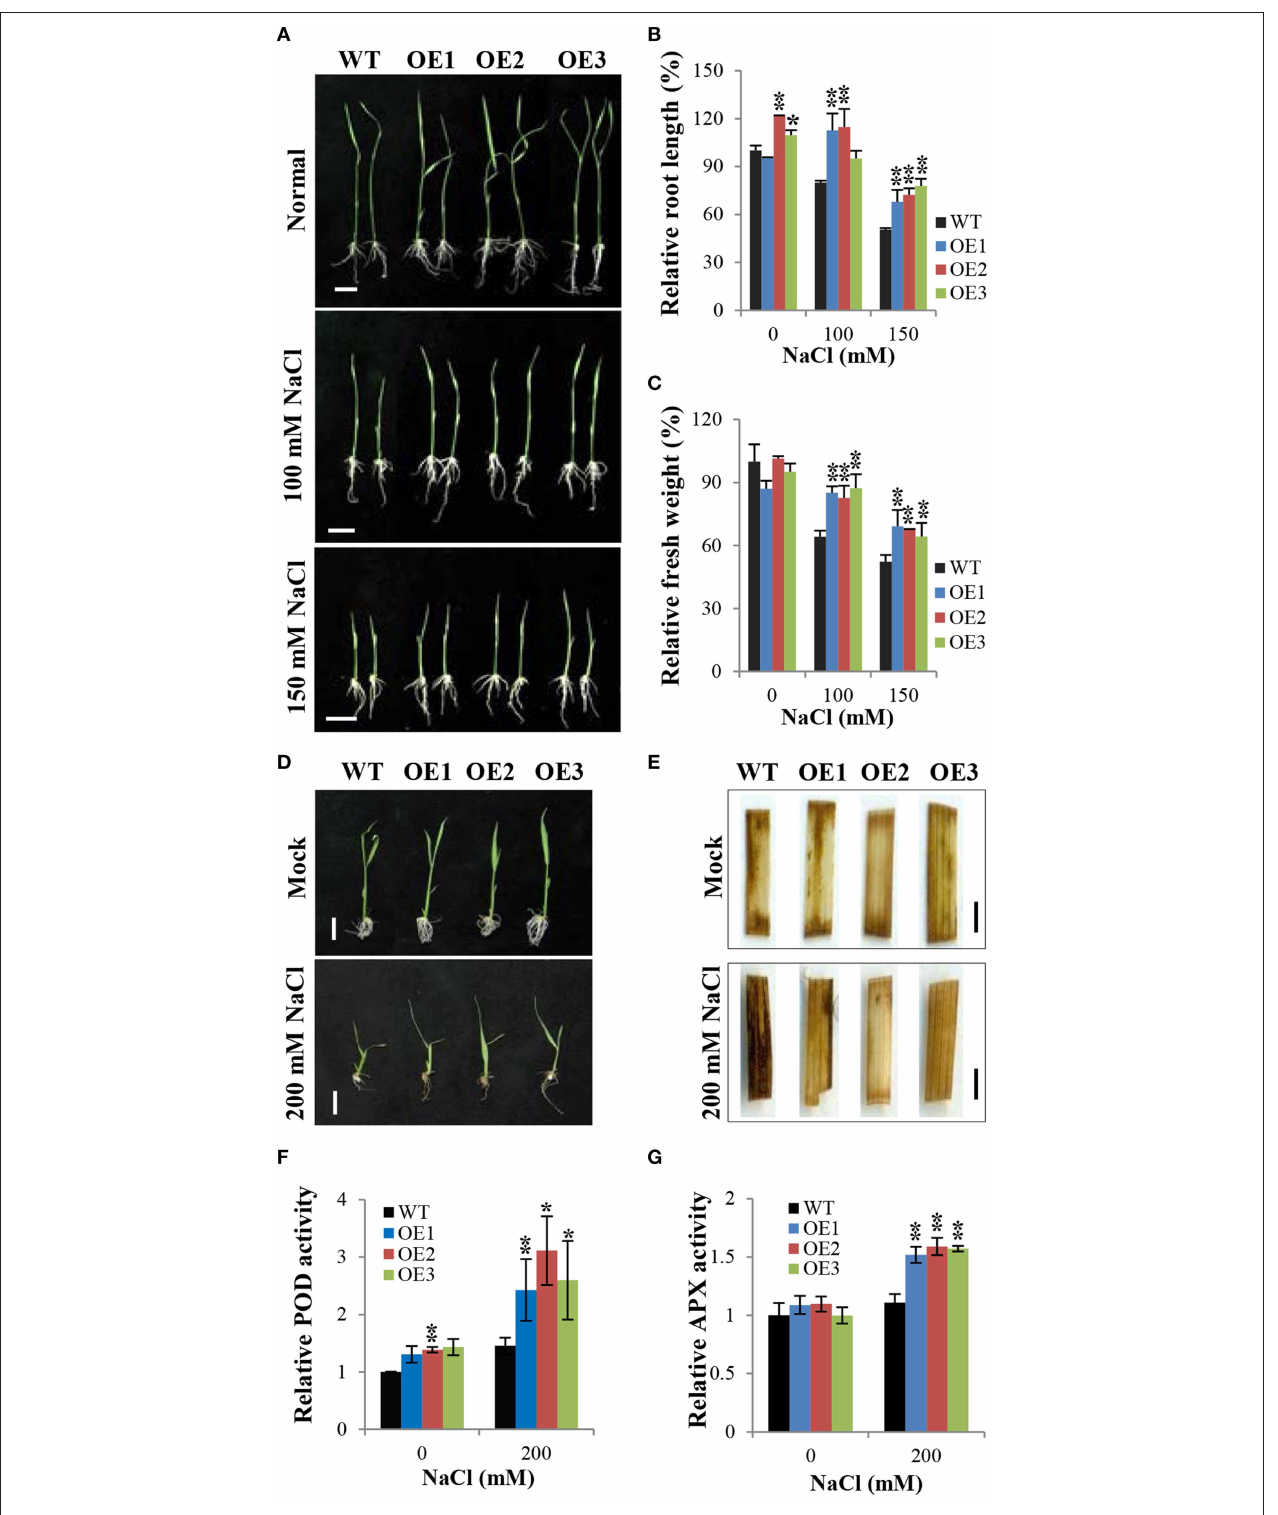
FIGURE 5 | Overexpression of OsCYP21-4 increases salt stress tolerance in rice. (A,D) Comparison of rice seedlings under NaCl stress. Transgenic plants (OE) and wild-type (WT) seeds were germinated on MS medium with or without hygromycin (50mg/L), respectively, and after 3 days, they were transferred to freshMSmediumplates (A) ortodistilledwatercontaining0,150or200mMNaCl (D) andgrownfor5days. (B,C) Relativerootlengthandfreshweightoftransgenicand